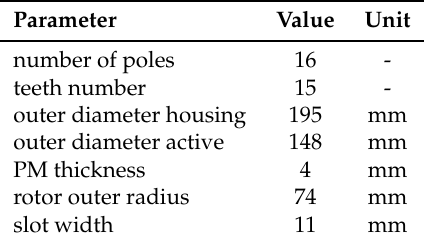
Table 2. YASA geometrical parameters.